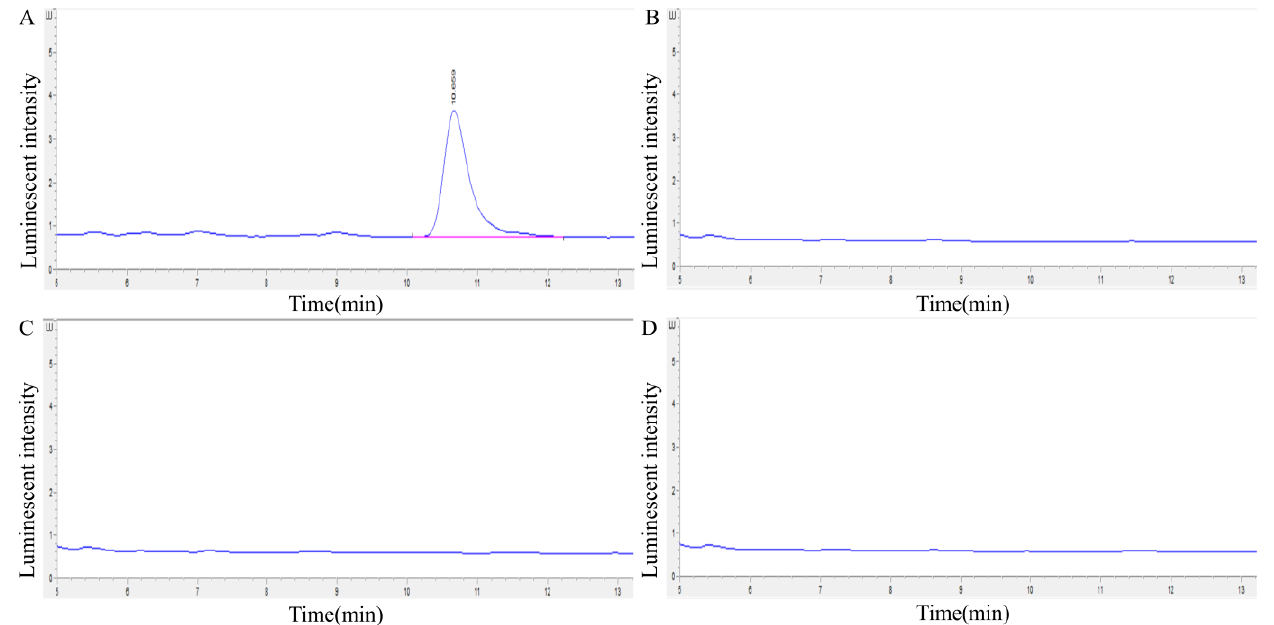
Figure 7. Analysis of the detoxification activity of transaminases by HPLC. ( A ) Chromatogram of HFB1; ( B ) Chromatogram of FumTSTA degradation of HFB1; ( C ) Chromatogram of FumPHTA degradation of HFB1; ( D ) Chromatogram of FumUPTA degradation of HFB1.